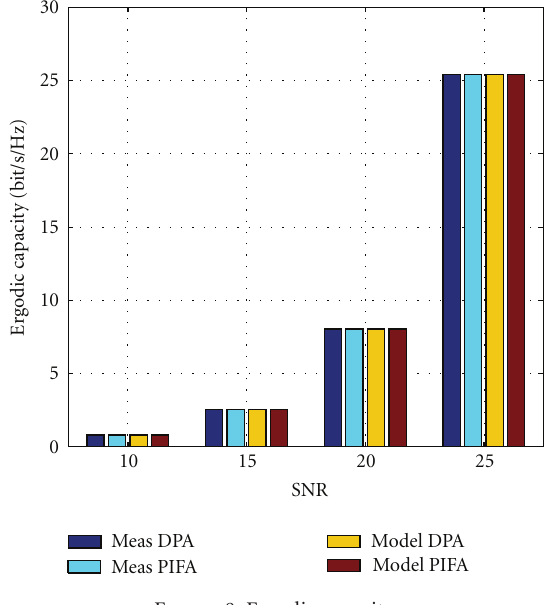
Figure 8: Ergodic